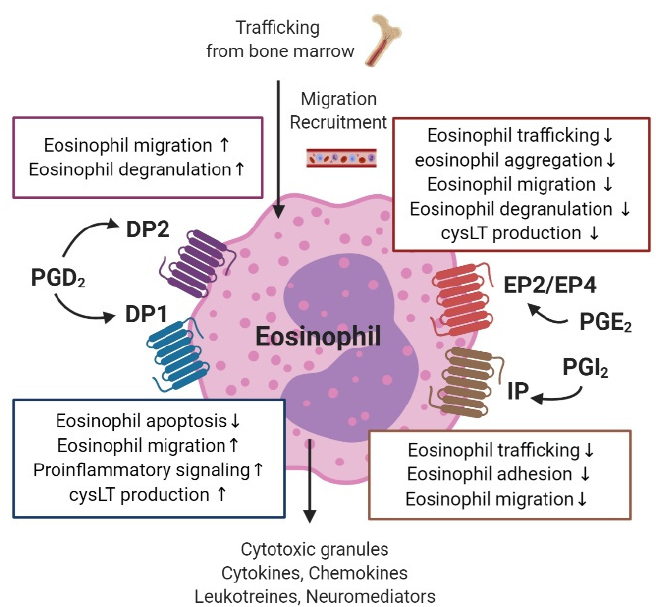
Figure 5. The role of prostaglandins and their receptors in eosinophil function, including bone marrow trafficking, migration, and degranulation.